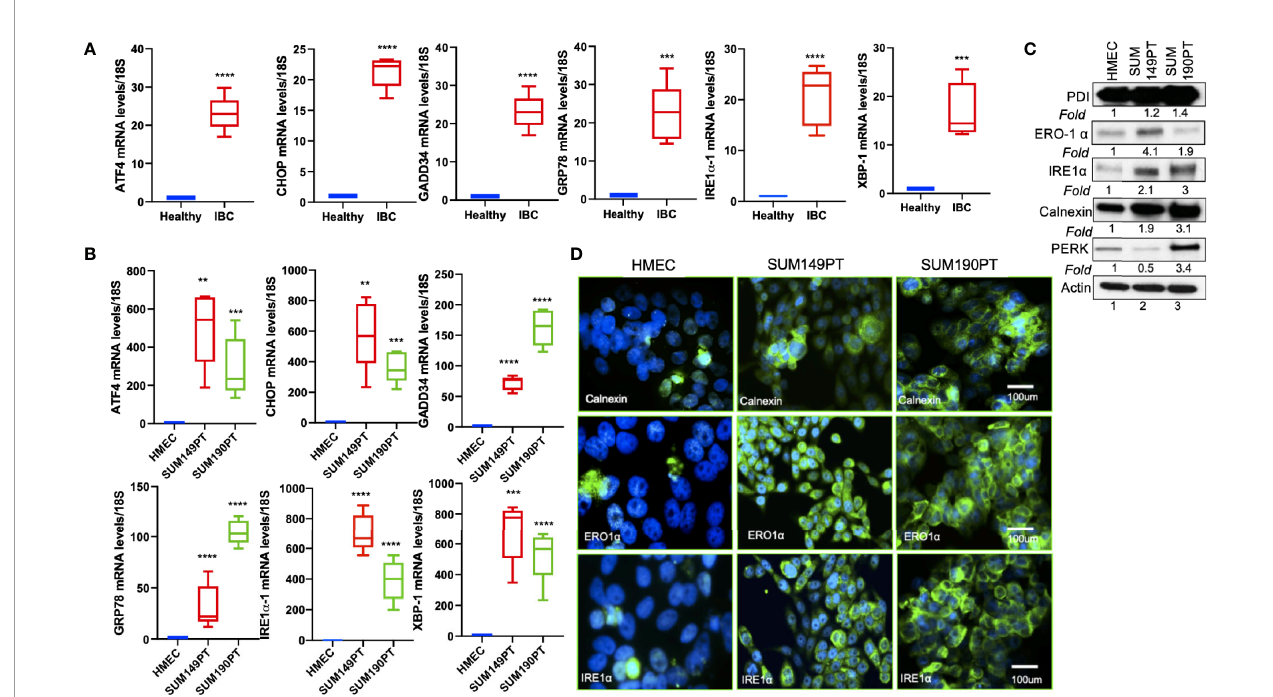
FIGURE 3 | ER stress genes are abundantly expressed in IBC tissue sections and IBC cell lines. (A) RNA isolated from healthy and IBC tumor tissue was prepared, converted to cDNA, and gene expression was quanti fi ed by real-time RT-PCR using speci fi c primers for ER stress markers as indicated. Each data point represents the average gene expression from six IBC and six healthy control samples. Each point represents the average ± the standard deviation of three experiments. (***) p<0.005, (****) p<0.001 indicates a statistically signi fi cant difference compared with healthy tissue. Each reaction was done in triplicate. (B) RNA isolated from HMEC, SUM149PT, and SUM190PT cells was converted to cDNA, and gene expression was quanti fi ed by real-time RT-PCR using speci fi c primers for ATF4, CHOP, GADD34, GRP78, IRE1 a , and XBP-1. Each point represents the average ± the standard deviation of three experiments. (**) p<0.01, (***) p<0.005, (****) p<0.001 indicate a statistically signi fi cant difference compared with HMEC cells. Each reaction was done in triplicate. (C) ER stress genes proteins are abundantly expressed in IBC cell lines. Lysates prepared from HMEC, SUM149PT, and SUM190PT cells, were tested for protein levels of PERK, IRE1 a , calnexin, ERO1 a , and PDI. Blots were reprobed with anti- b -actin antibody as a loading control for normalization. Fold expression of each protein was calculated by considering the expression of the protein in HMEC as 1. (D) Immunostaining of HMEC and SUM149PT cells seeded in eight-well chamber slides. Cells were fi xed, permeabilized, and then stained with primary monoclonal antibodies against ER stress markers, including calnexin, ERO1 a , and IRE1 a . Cells were developed with Alexa-488 coupled secondary antibody (green). Nuclei were visualized using DAPI as the counterstain